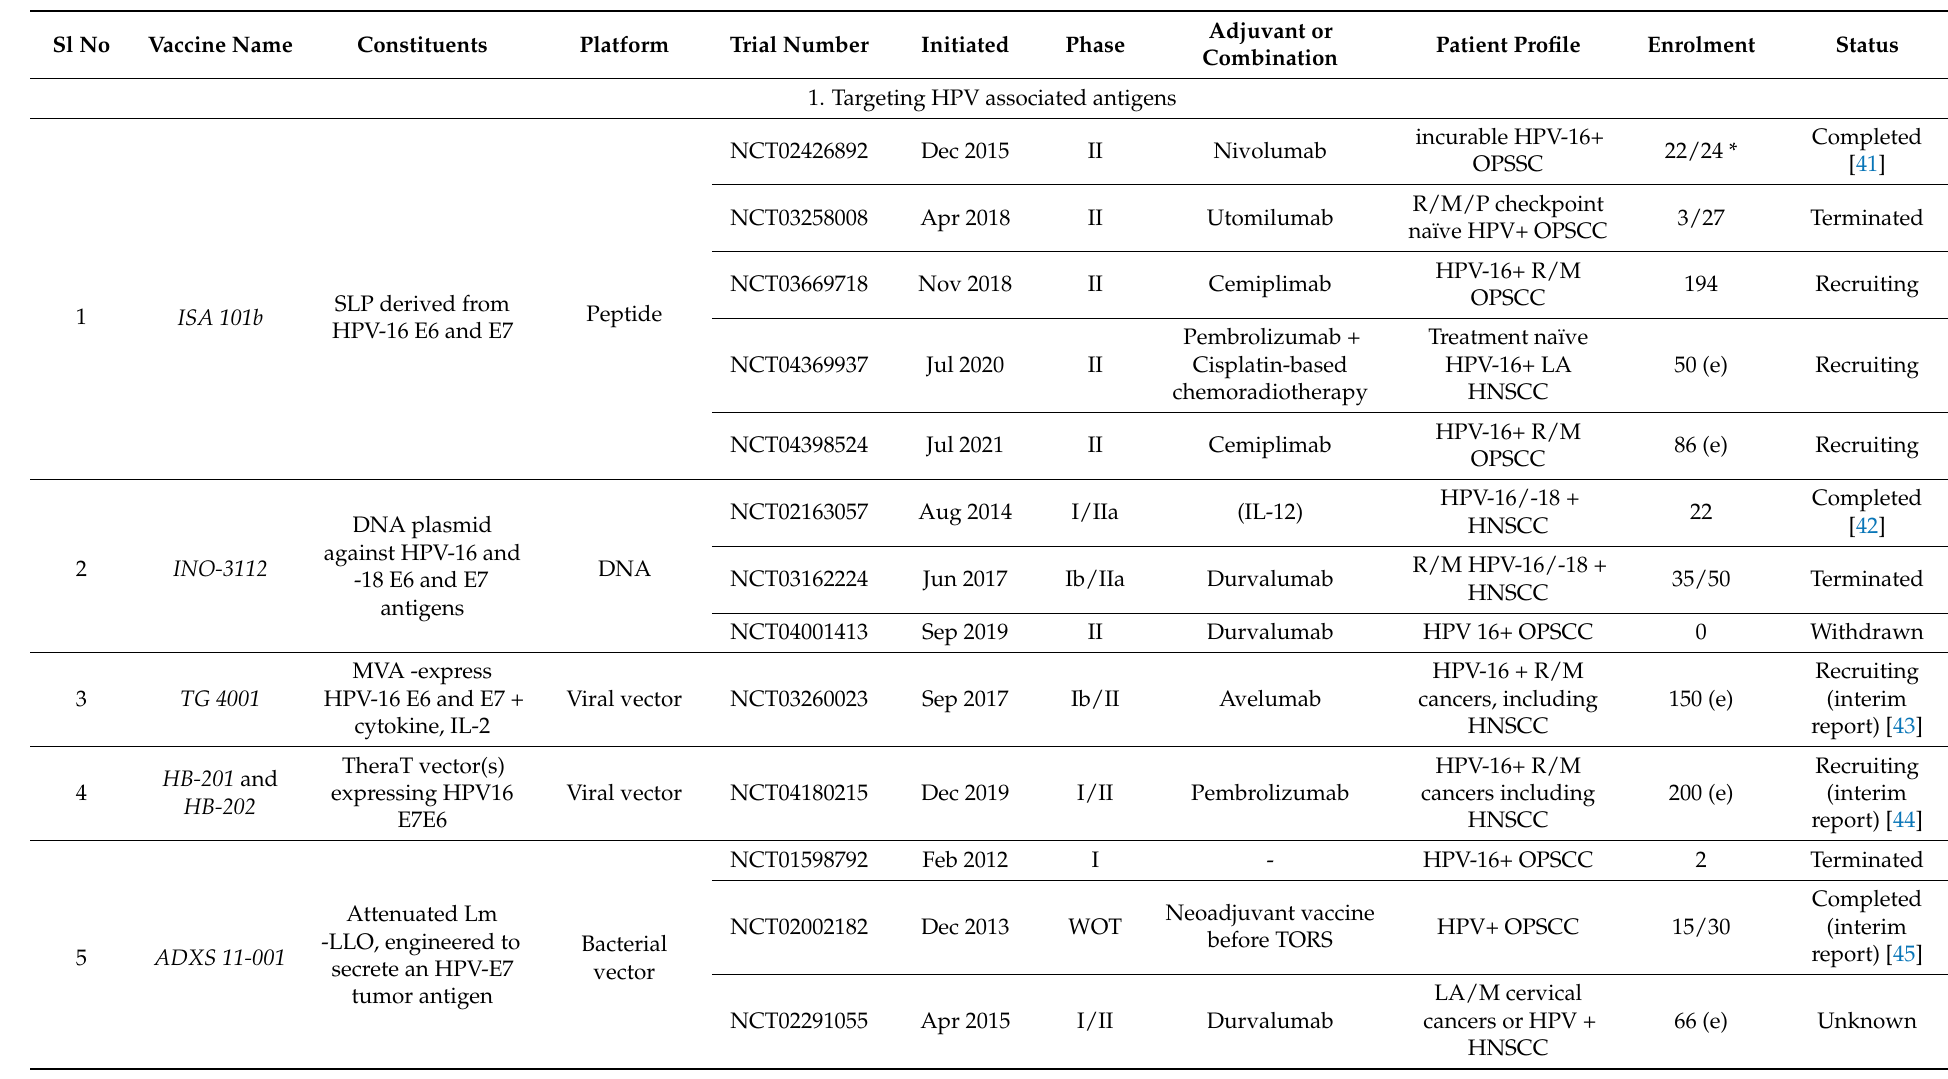
Table 2. Detailed list of major trials related to therapeutic vaccines for